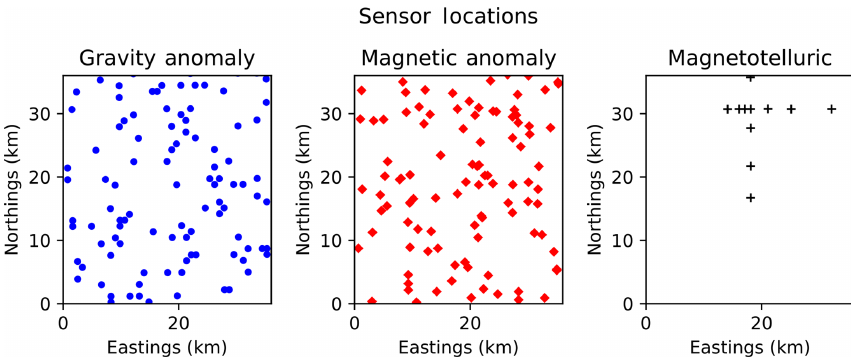
Figure 2. Locations of sensor readings used in the inversions in this paper. Table 1. Performance metrics for each run, including the following: best-case ( τ i, min ), median ( τ i, med ), and worst-case ( τ i, max ) autocorrela- tion times for model parameters; standard deviations, σ grav and σ mag , of residuals of the posterior mean forward model predictions for the gravity anomaly and magnetic anomaly data; volume-average information entropy S ; number of chain iterates N samples (with each iterate representing a single evaluation of all forward models for a given set of world parameters); and CPU hours per autocorrelation time (i.e., the computational cost of obtaining a single independent sample from the